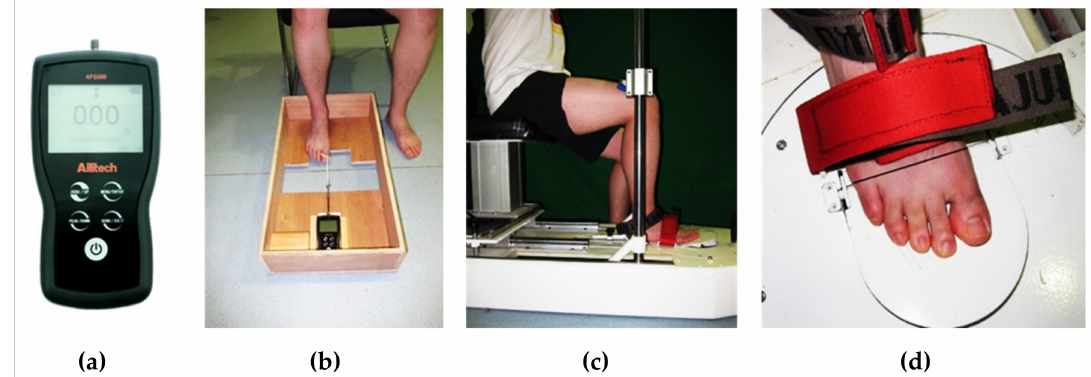
Figure 2. ( a ) Digital display dynamometer; ( b ) The experimental setup of toe flexor strength of measurement; ( c , d ) Metatarsophalangeal joint flexor strength tester, and the experimental setup.